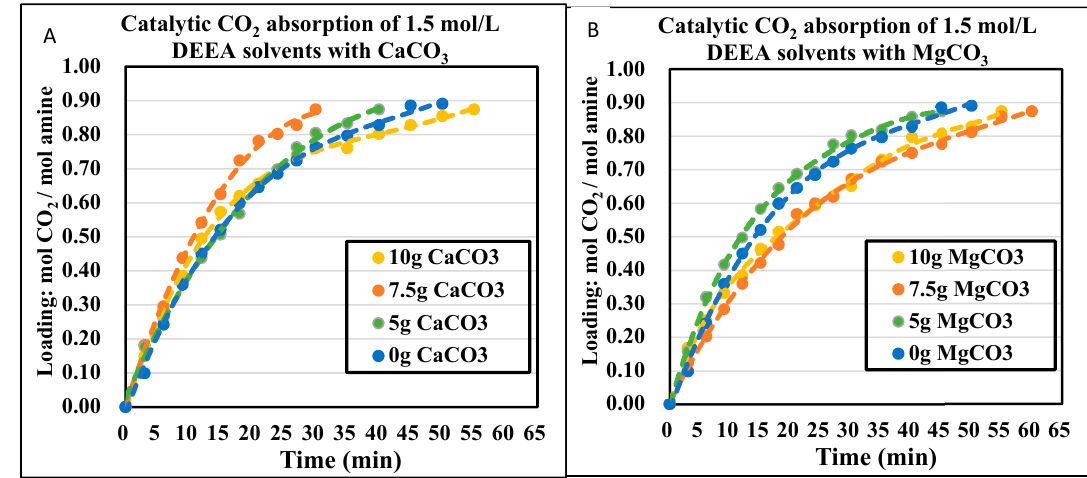
Figure 4. Catalytic CO 2 absorption curves of 1.5 mol/L DEEA solvents at 293 K and 1 atm. ( A ) CaCO 3 0–10 g ( B ) MgCO 3 0–10 g. Table 2. The optimized mass of CaCO 3 and MgCO 3 for different amine solvents at 293 K and 1 atm.